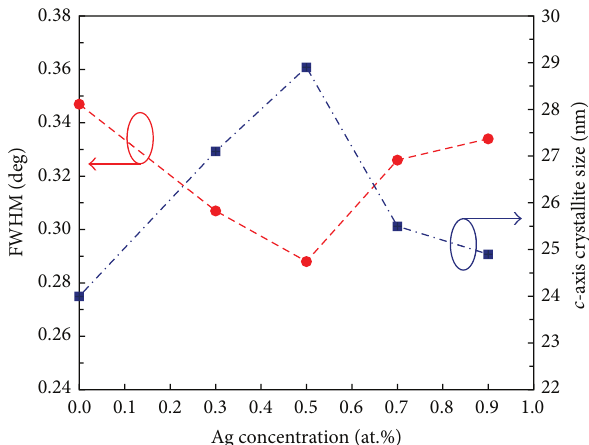
Figure 3: FWHM and c -axis lattice crystallite size of undoped and Ag doped ZnO thin